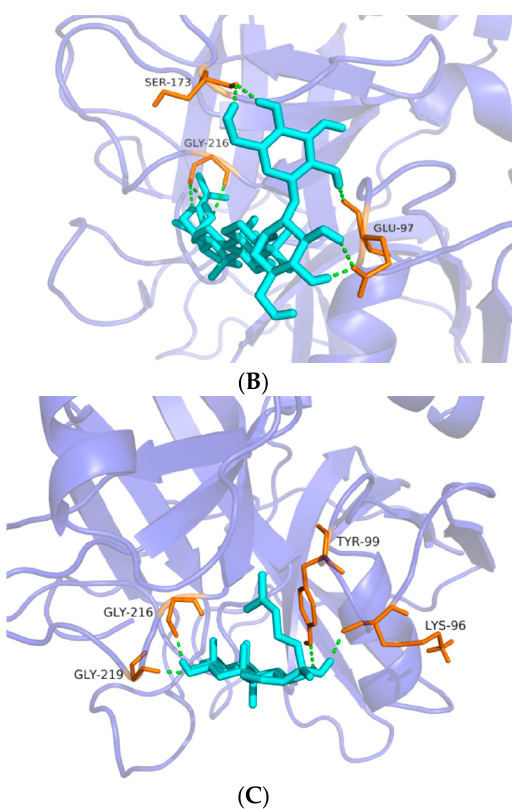
Figure 6. Interaction modes of ginsenosides 5 , 13 and 18 within FXa binding pocket ( A – C ). ( A ) H-bonds between Rg2 ( 5 ) and FXa pocket; ( B ) H-bonds between Rg3 ( 13 ) and FXa pocket; ( C ) H-bonds between PPT ( 18 ) and FXa pocket; light blue, ligands (Rg2, Rg3 and PPT); pink, ligands; orange, residues of the binding protein (FXa); green dashed line, H-bond.